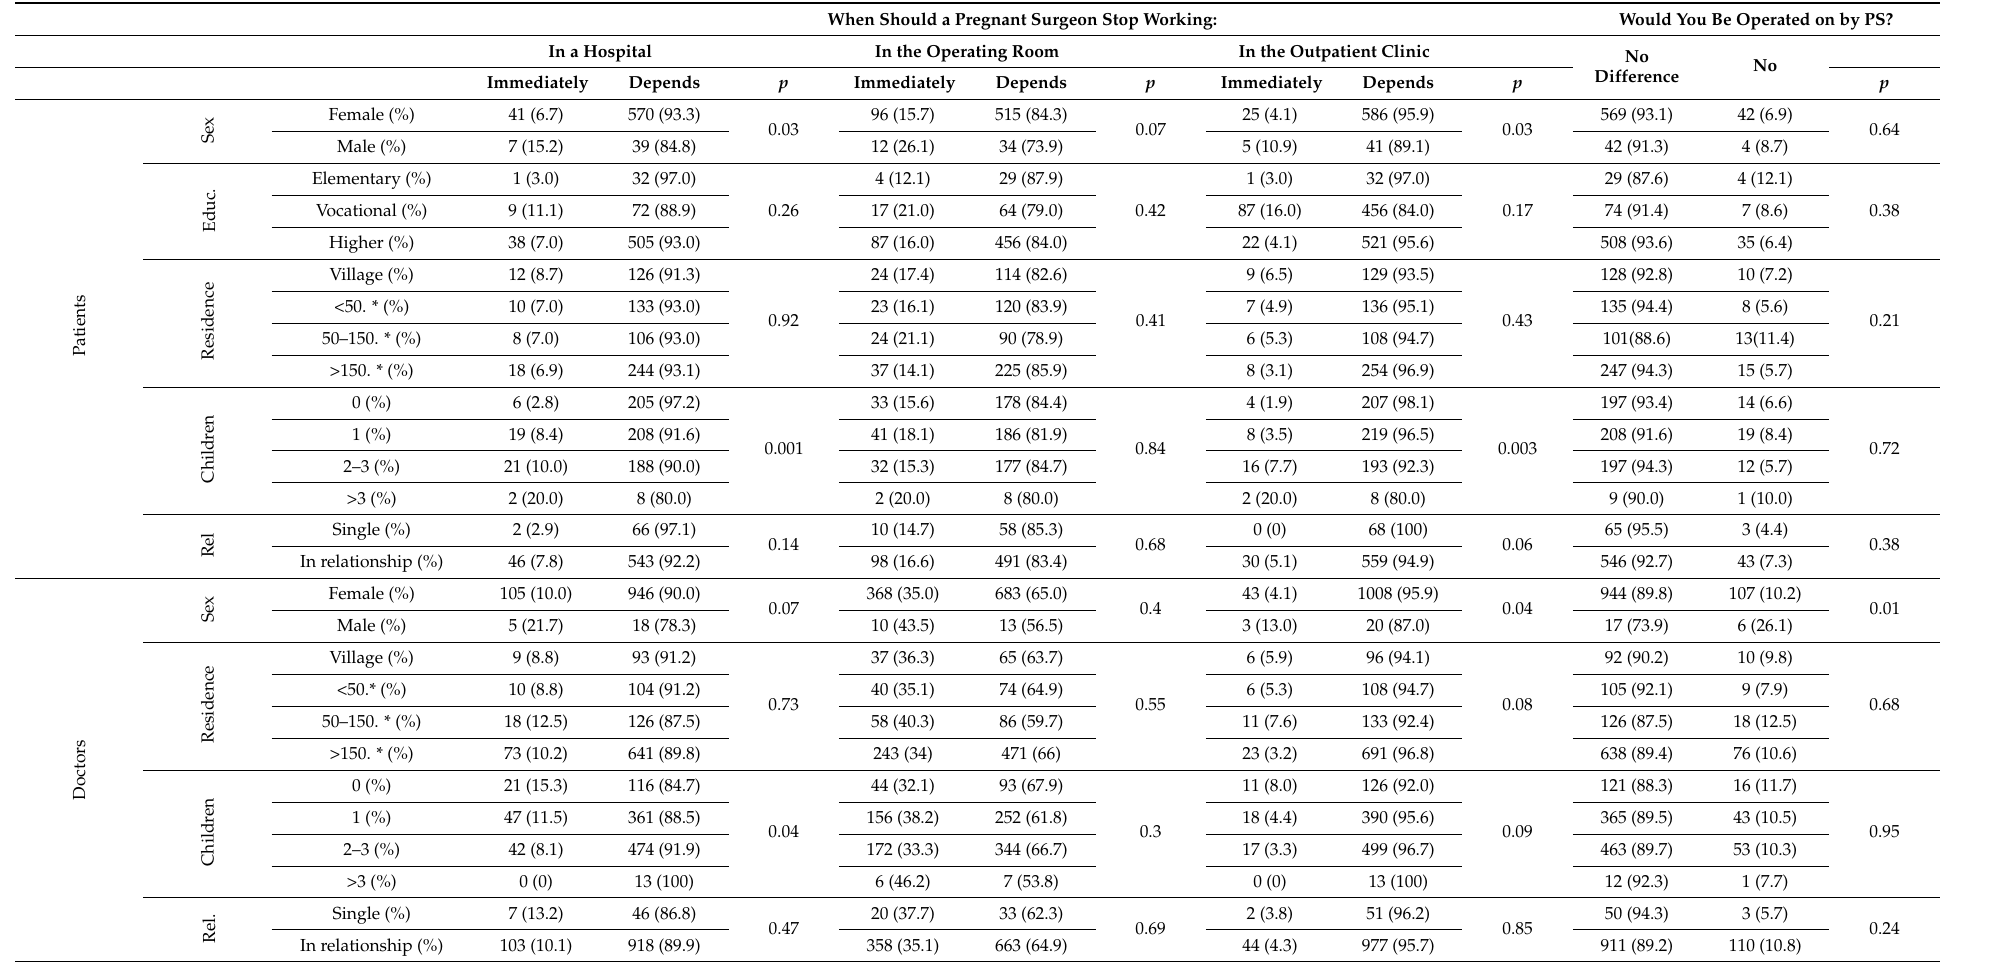
Table 4. Correlation between demographic factors and responders’ answers. (* thousand inhabitants; educ. education; rel.